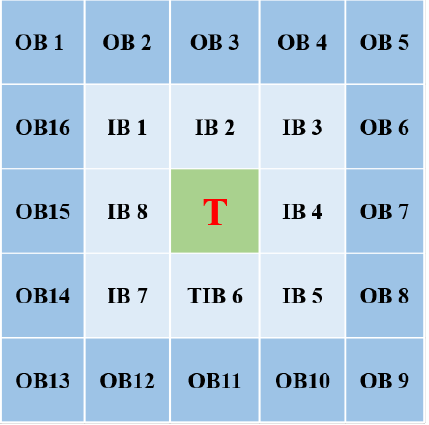
Figure 7. An introduction to the three-layer window